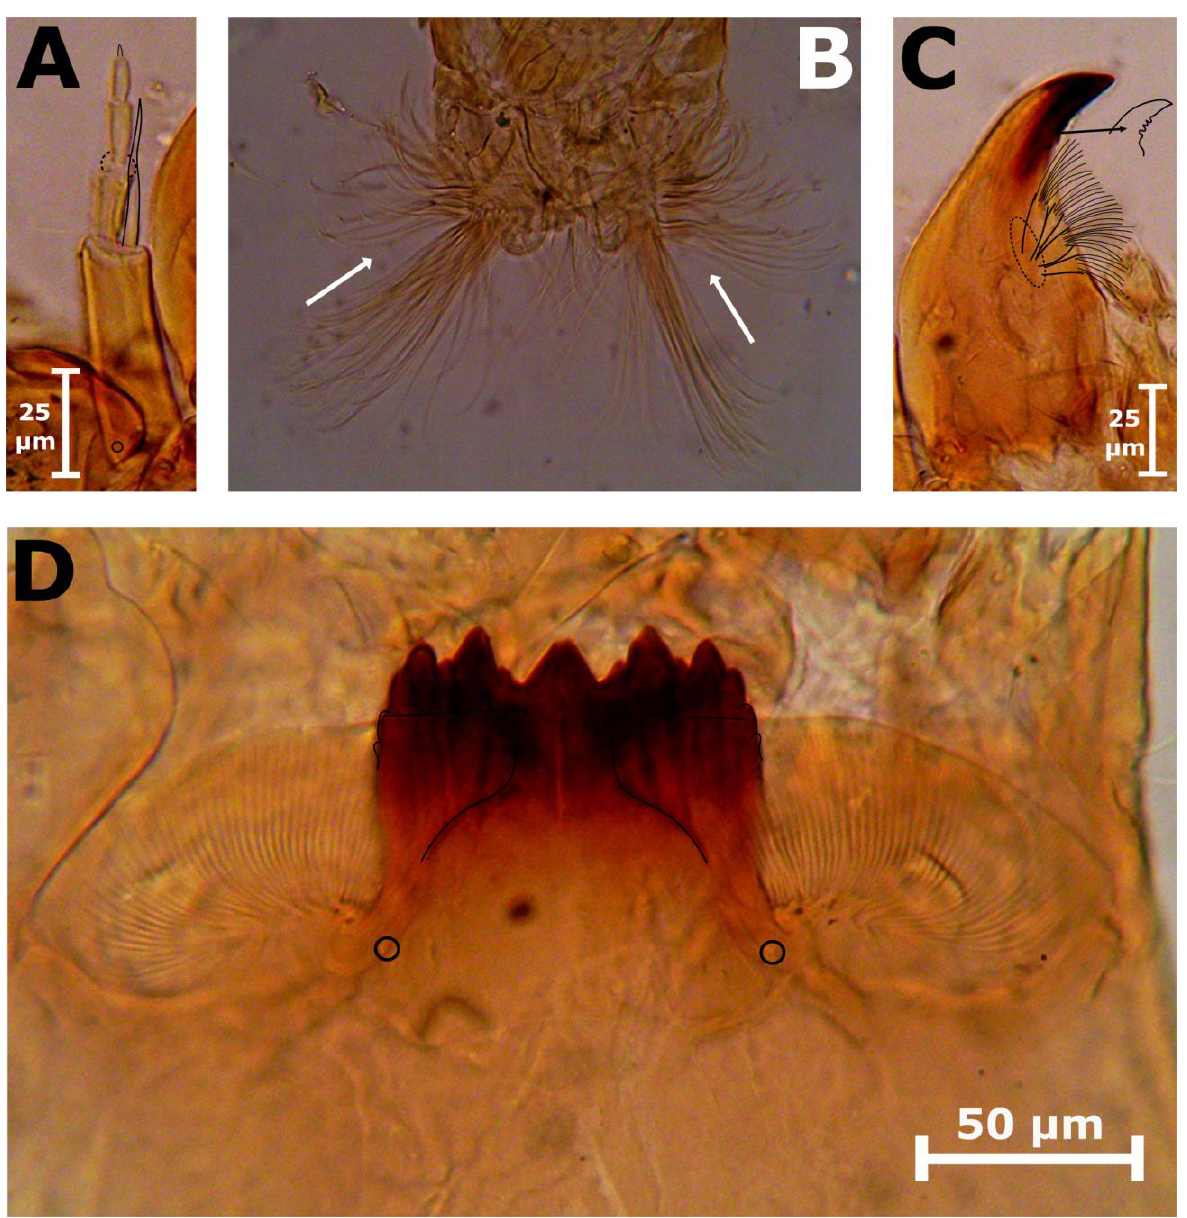
F IGURE 2. Xenochironomus xenolabis (Kieffer, 1916), A-D larva. Antenna (A); Labro-epipharyngeal region, arrow indicate the cluster of tick setae (B); Mandible (C); Mentum (D). Diagnosis - Pupa : Thorax granular. Thoracic horn 277–281 (279) μm long with circular plastron plate, plastron plate about 1/3 rd of the thoracic horn, atrium of thoracic horn thin-walled, joined with a short neck to the plastron plate, thoracic horn 4.3 x as long as wide (Fig. 1a). Tergite I with conspicuous scar (Fig. 1b). Tergite VII with 3 taeniae lateral setae, tergite VIII with 4 taeniae lateral setae, anal lobe 3 x as long as wide, anterior taeniae of anal lobe at 0.35 of lobe length (Fig. 1c). Remarks : This species was described by Walker (1856) as Chironomus divisus . Adult male is described in key by Langton & Pinder (2007). The pupa is described by Langton & Visser (2003). The larva of this species is probably the Paramerina sp. described by Mohammadi et al . (2020) from the same